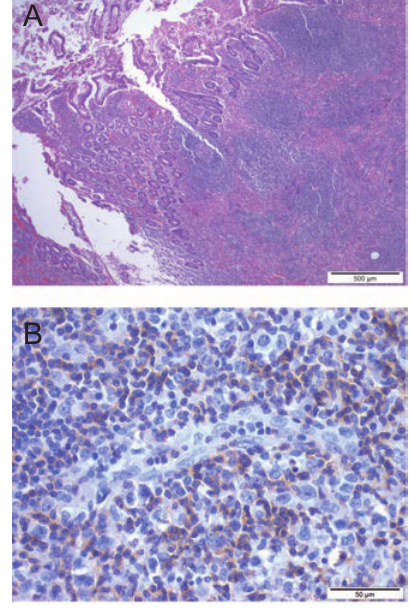
Figure 1. A) Low-power view of the lym- phoma, involving the intestinal wall and ulcerating the mucosa (HE staining). B) Immunoreactivity for CD3 in small and intermediate-size neoplastic cells; large cells have lost positivity for CD3.